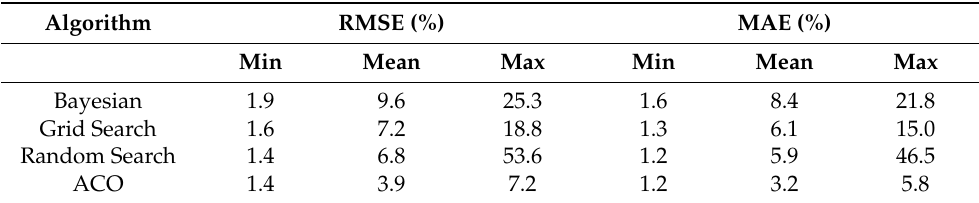
Table 3. RMSE and MAE results for a set of 15 simulations of different optimization